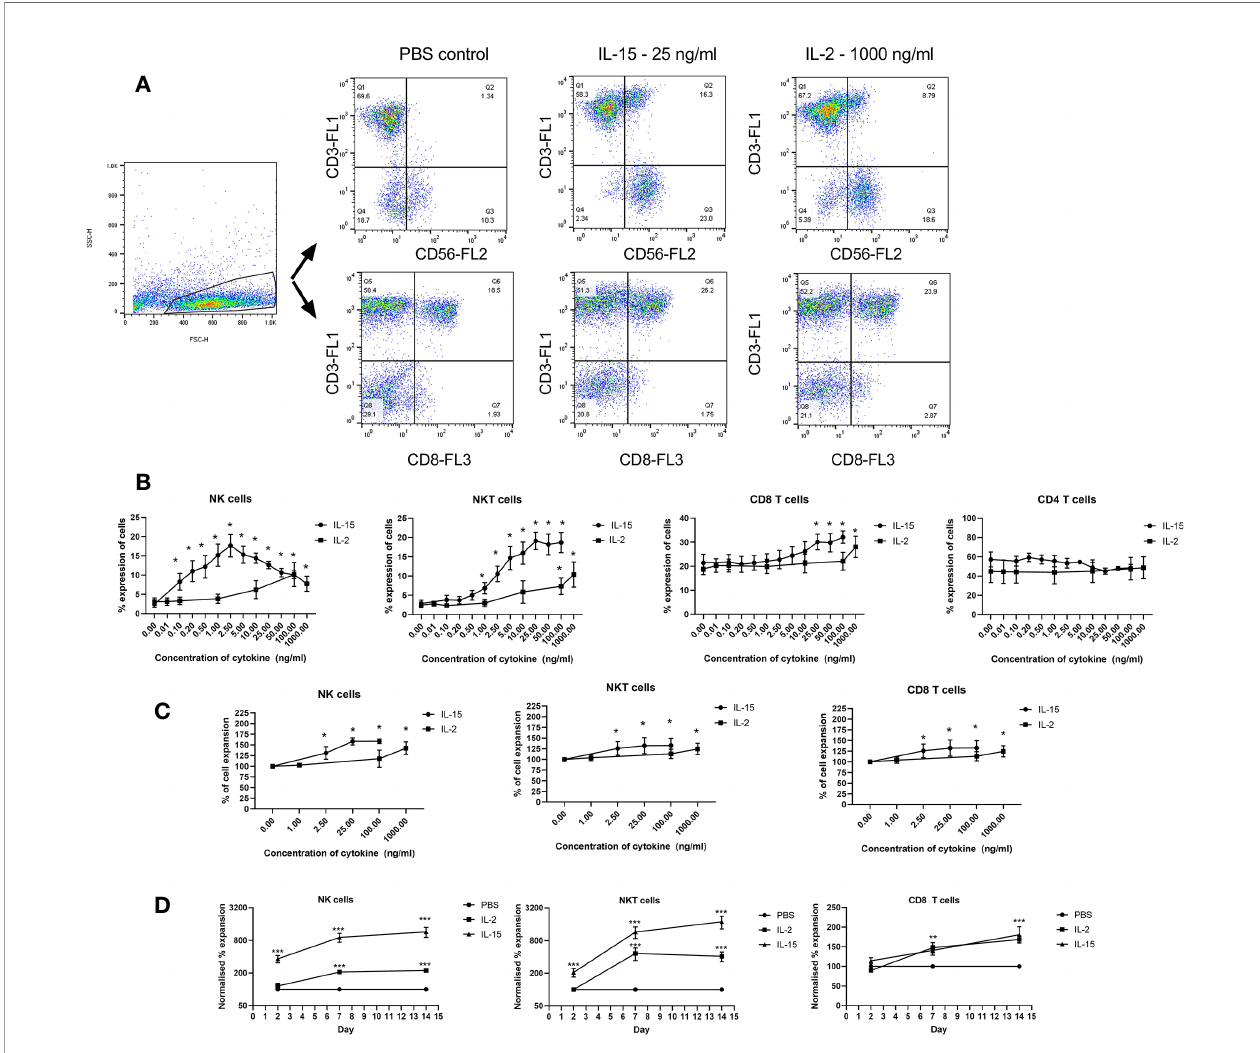
FIGURE 1 | Expansion of immune effector cell populations treated for 7 days with IL-15 at concentrations from 0.01 ng/ml to 100 ng/ml or IL-2 from 0.1 to 1000 ng/ml with PBS as a control. (A) Gating strategy for NK cells, NKT-like cells and CD8 T cells in the PBMC population showing the signi fi cant increase in CD56+CD3- cells (NK cells), CD56+CD3+ (NKT cells) and (CD3+CD8+) (CD8 T) cells in non-adherent PBMCs treated with IL-15. (B) displays quantitated expression of NK, NKT, CD8 T cells and CD4 T cells in lymphocytes treated with different doses of IL-15 or IL-2. (C) shows increased total percentage of puri fi ed NK, NKT, and CD8 T cells upon incubation with IL-2 or IL-15. (D) shows the expansion of the three cell types over a time period with time points at days 2, 7, and 14 using IL-15 at 2.5 ng/ml for NK cells and 25 ng/ml with a more pronounced expansion with IL-15 compared to IL-2 in NK and NKT-like cells. Results are expressed as % of the expansion of the untreated lymphocytes and represent means ± SEM from six separate experiments (*p < 0.05, **p < 0.01 and ***p < 0.001 by one-way ANOVA and Newman Keuls post-hoc